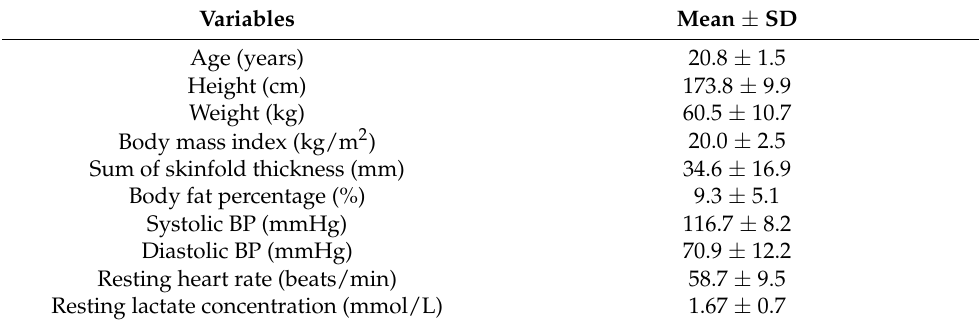
Table 1. Participant Characteristics ( n =